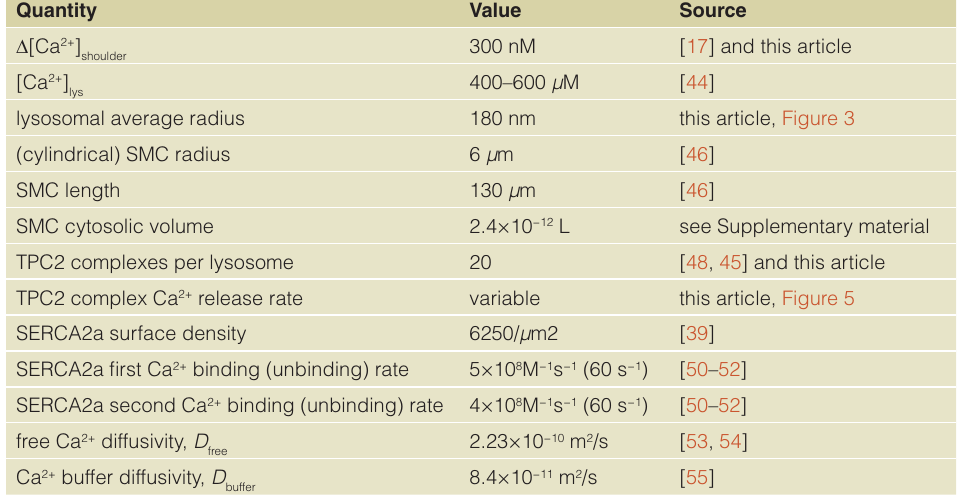
Table 2. Quantitative model input